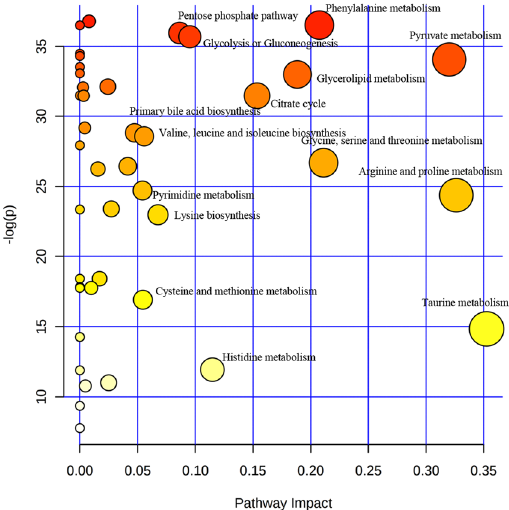
Figure 5. Metabolic pathway analysis. The χ -axis represents the pathway impact, and the y- axis represents the − log ( p ). The pathway analysis result showed the metabolic network reprogramming of PBC with detailed impact.